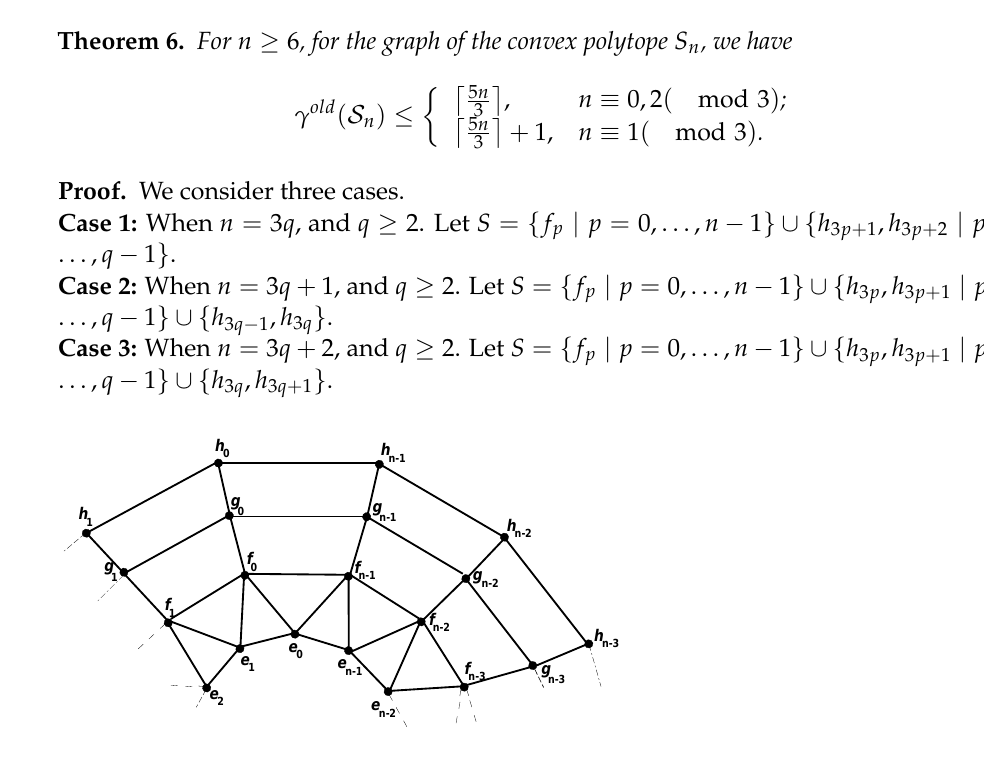
Figure 9. The graph of convex polytope S n .